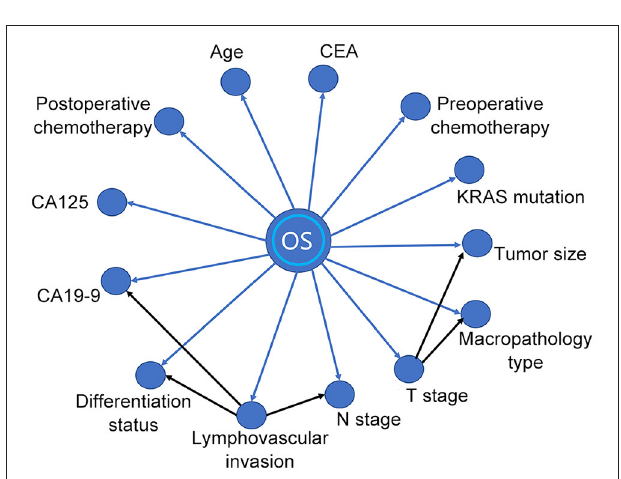
FIGURE 2 | A Bayesian network (BN) model for prognostic factors of the training